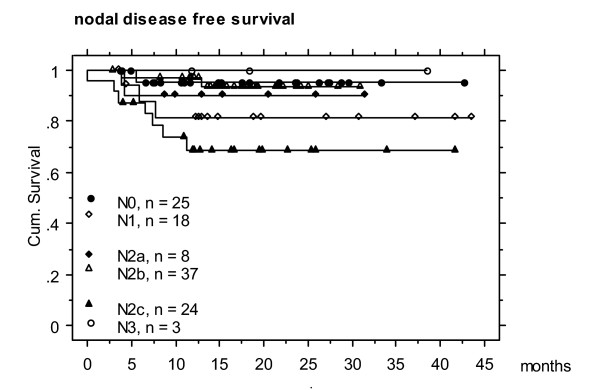
Actuarial 2 year nodal disease free survival according to N stages (N0 patients remain nodally controlled)